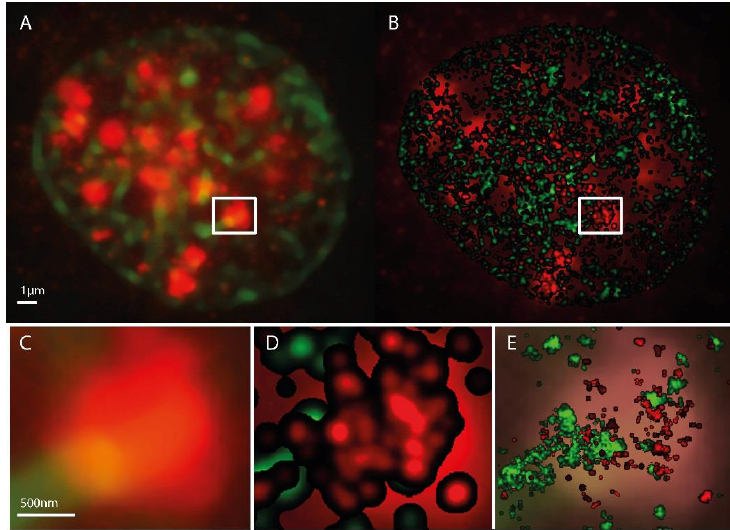
Figure 1. Microscopy images of H3K9me3 (green) and γH2AX (red) immunostaining in a SkBr3 cell nucleus 30 min after irradiation with 1 Gy, 6 MeV photons. ( A ) conventional widefield microscopy image. ( B ) SMLM image represented as a density image where the brightness of a point refers to the number of next neighbor points. In the background the conventional widefield microscopy image of γ H2AX fluorescence is shown. The SMLM image is created from the coordinate matrix where the pixel geometry and intensity is stored in pixel values. After determination of the pixel size in nm, the coordinates and distances can be evaluated. In a fixed radius R around each coordinate, it is determined how many further coordinates are within this radius. This value is coded in the intensity of the coordinate point. In order to emphasize contiguous structures, each coordinate with an assigned value greater than zero is the starting point of a Gaussian distribution with a given sigma. The sum of all Gaussian distributions then represents the intensity distribution of the Gaussian-filtered density image (example: pixel size = 10 nm/pixel, Radius R = 1000 nm, Gaussian filter σ = 50 nm). ( C ) magnified insert from ( A ). ( D ) magnified insert of ( B ). ( C , E ) superposed by the standard localization image. This supposing